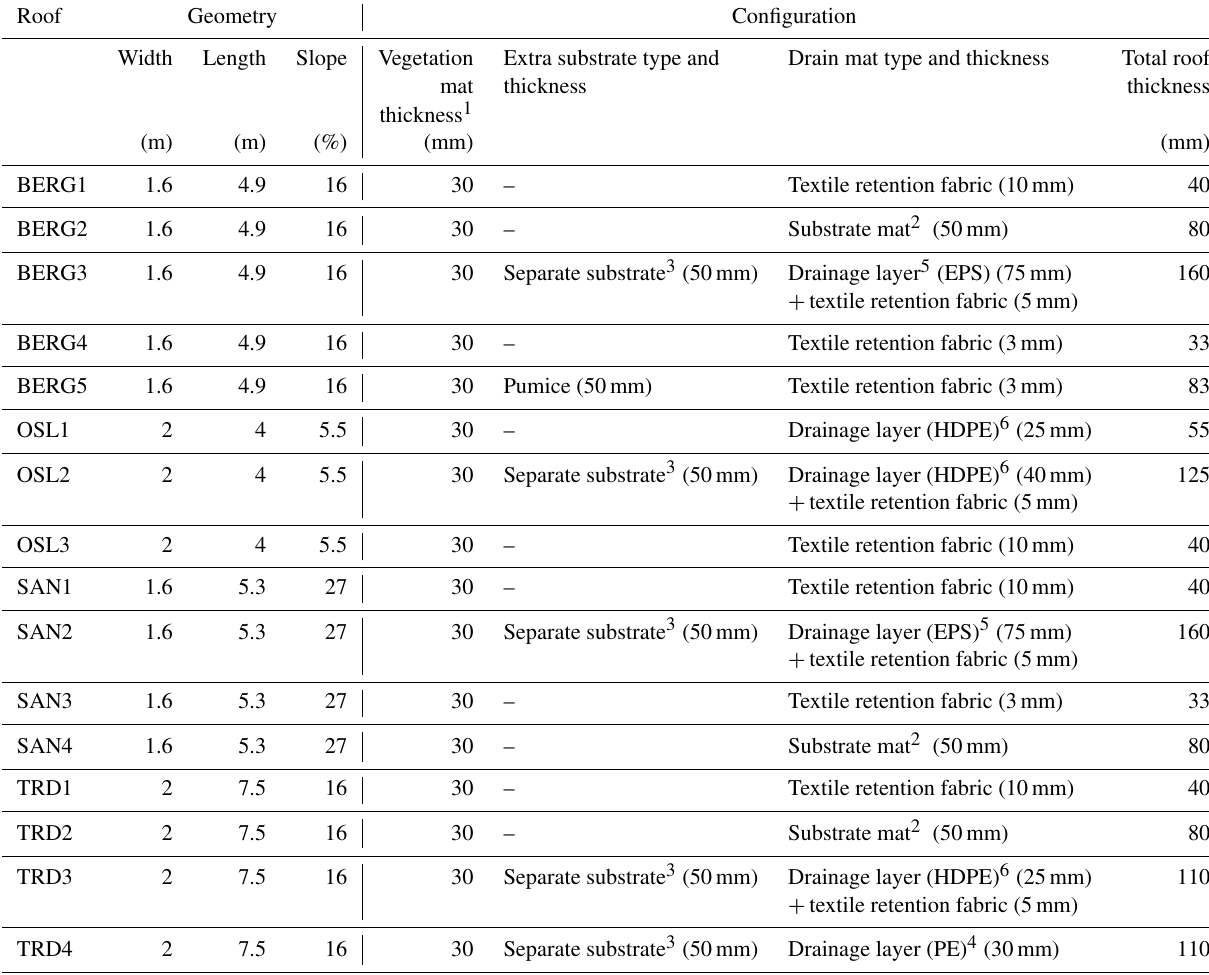
Table 1. Roof Geometries and Configurations. Roof Geometry